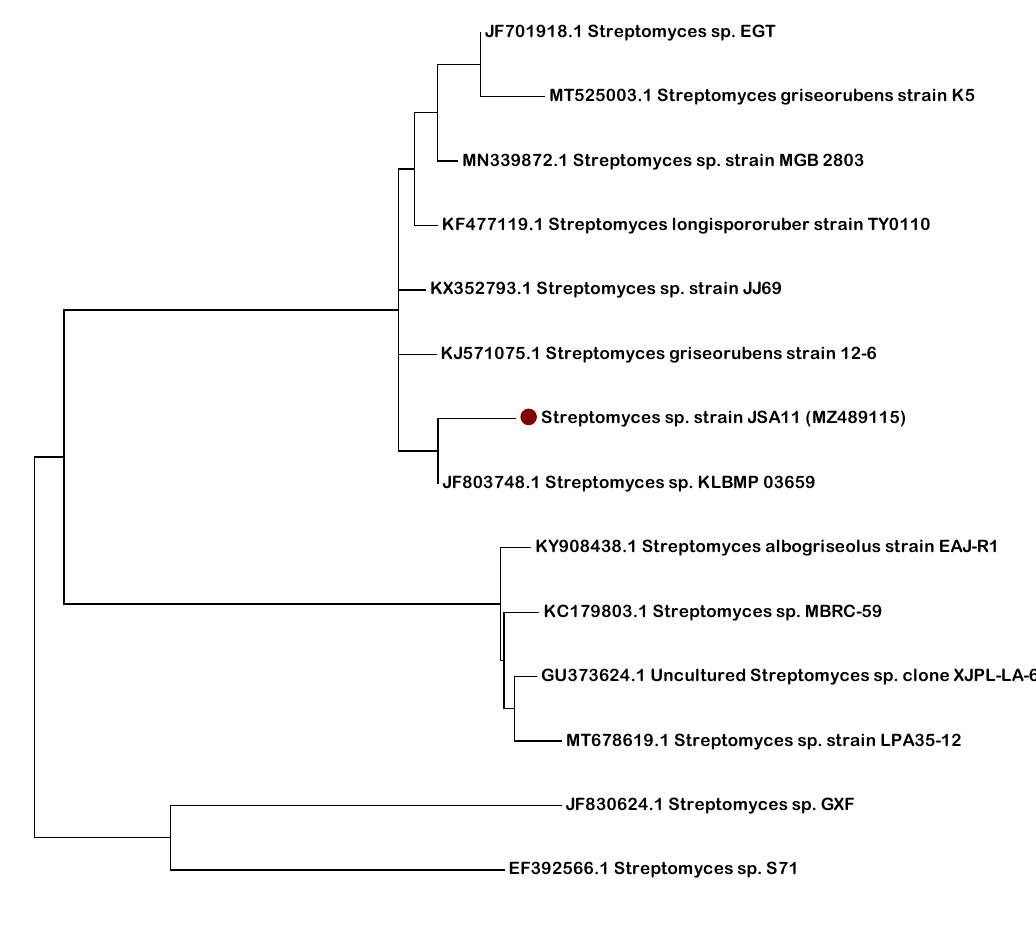
Figure 1. Neighbor joining tree (partial sequences ~ 950 bp) showing the phylogenetic relationships of actinobacterial 16S rRNA gene sequence of potential strains to closely related (S ≥ 97%) sequences from the GenBank database.